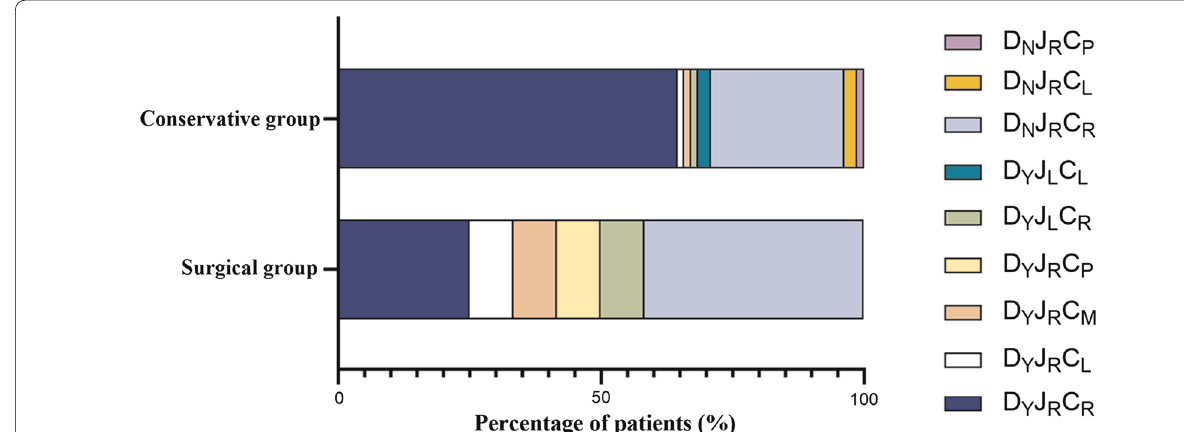
Fig. 5 Distribution of CT classification of patients in the surgical and conservative groups